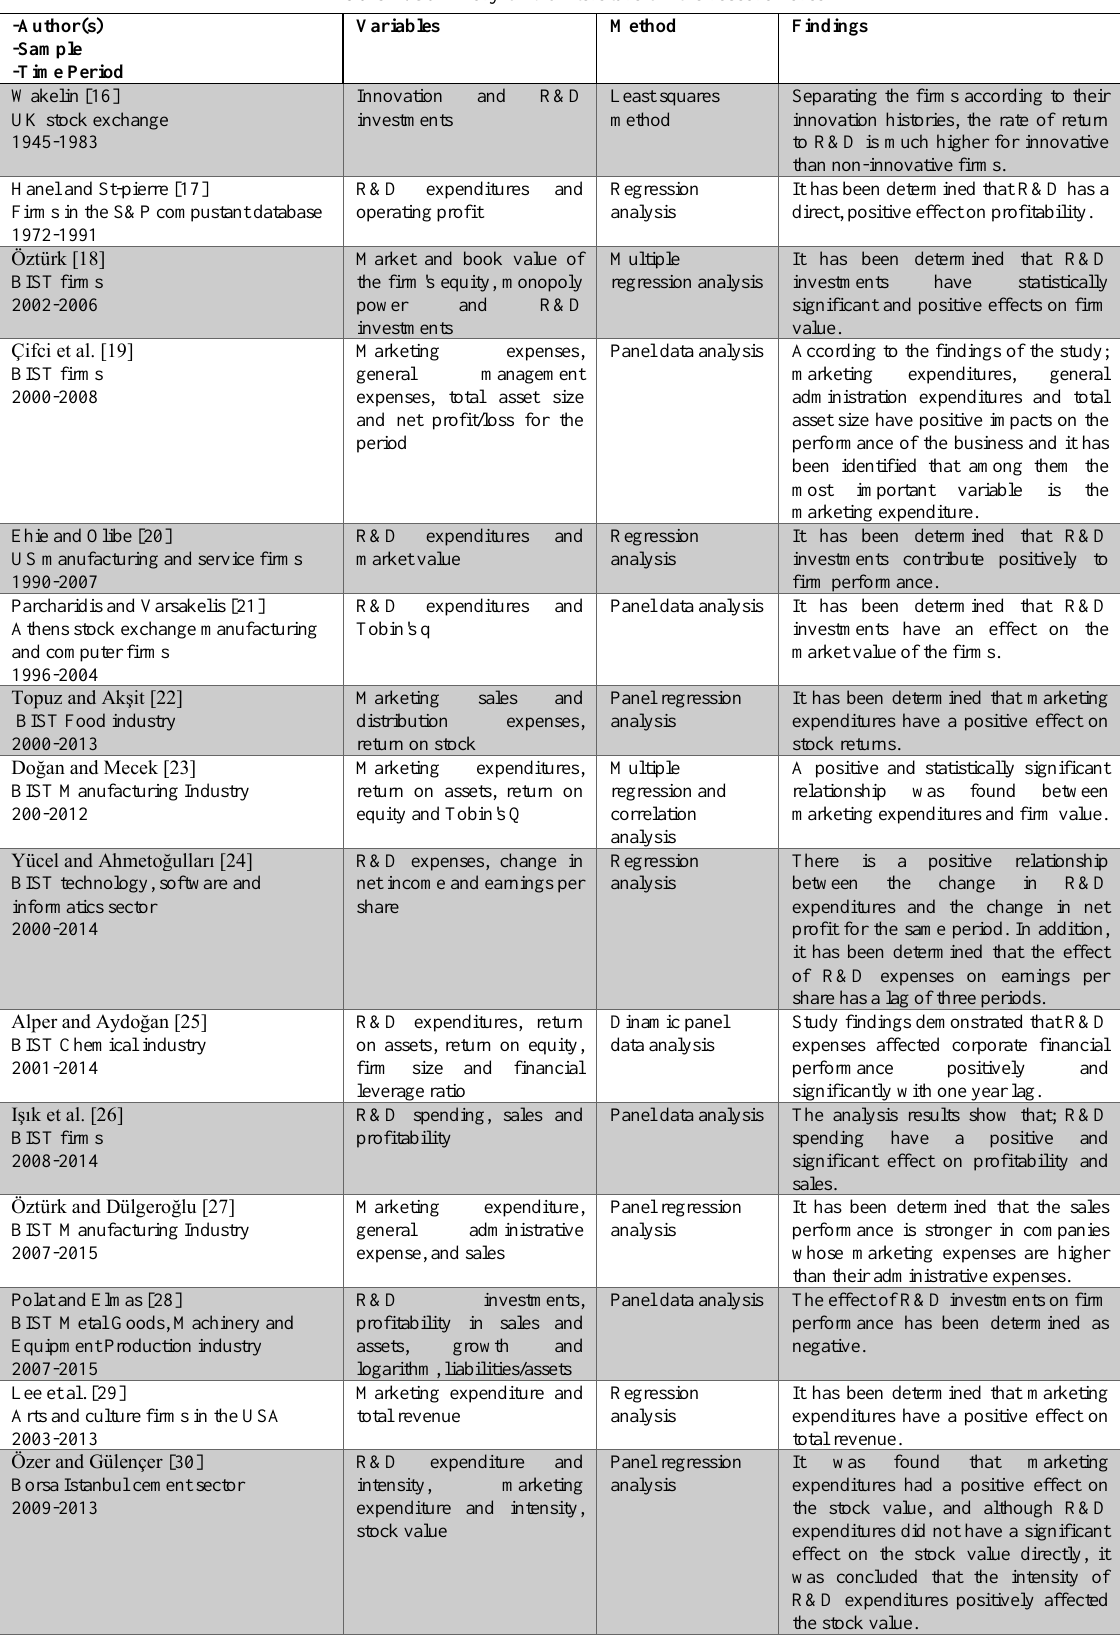
Table 1. Summary of the literature on the research